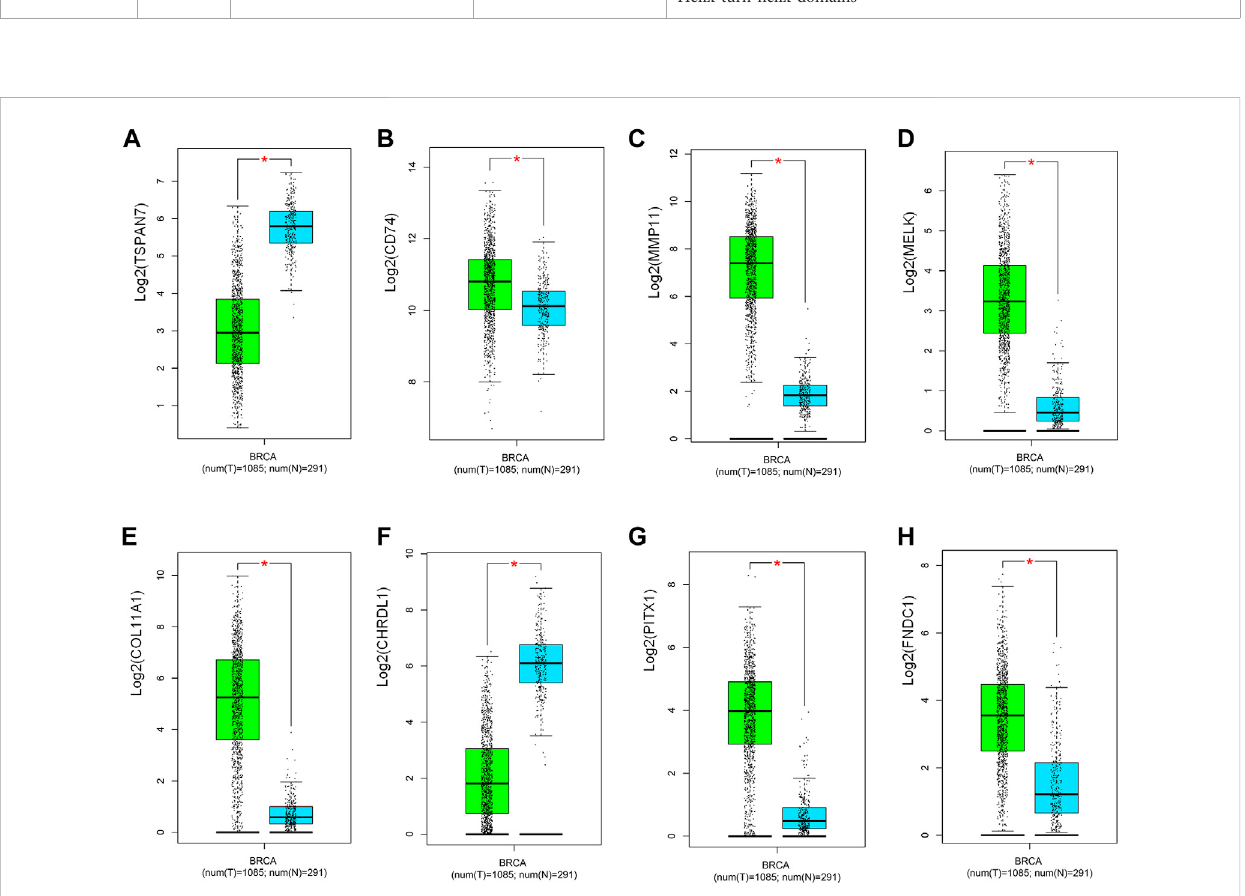
FIGURE 4 Validation of the expression of potential predictive biomarker in TCGA and GETx ( n = 1,376). (A) TSPAN7, (B) CD74, (C) MMP11, (D) MELK, (E) COL11A1, (F) CHRDL1, (G) PITX1, (H) FNDC1. T: tumor; N: normal. Green and blue, respectively indicate tumor and normal groups. * p < 0.05.